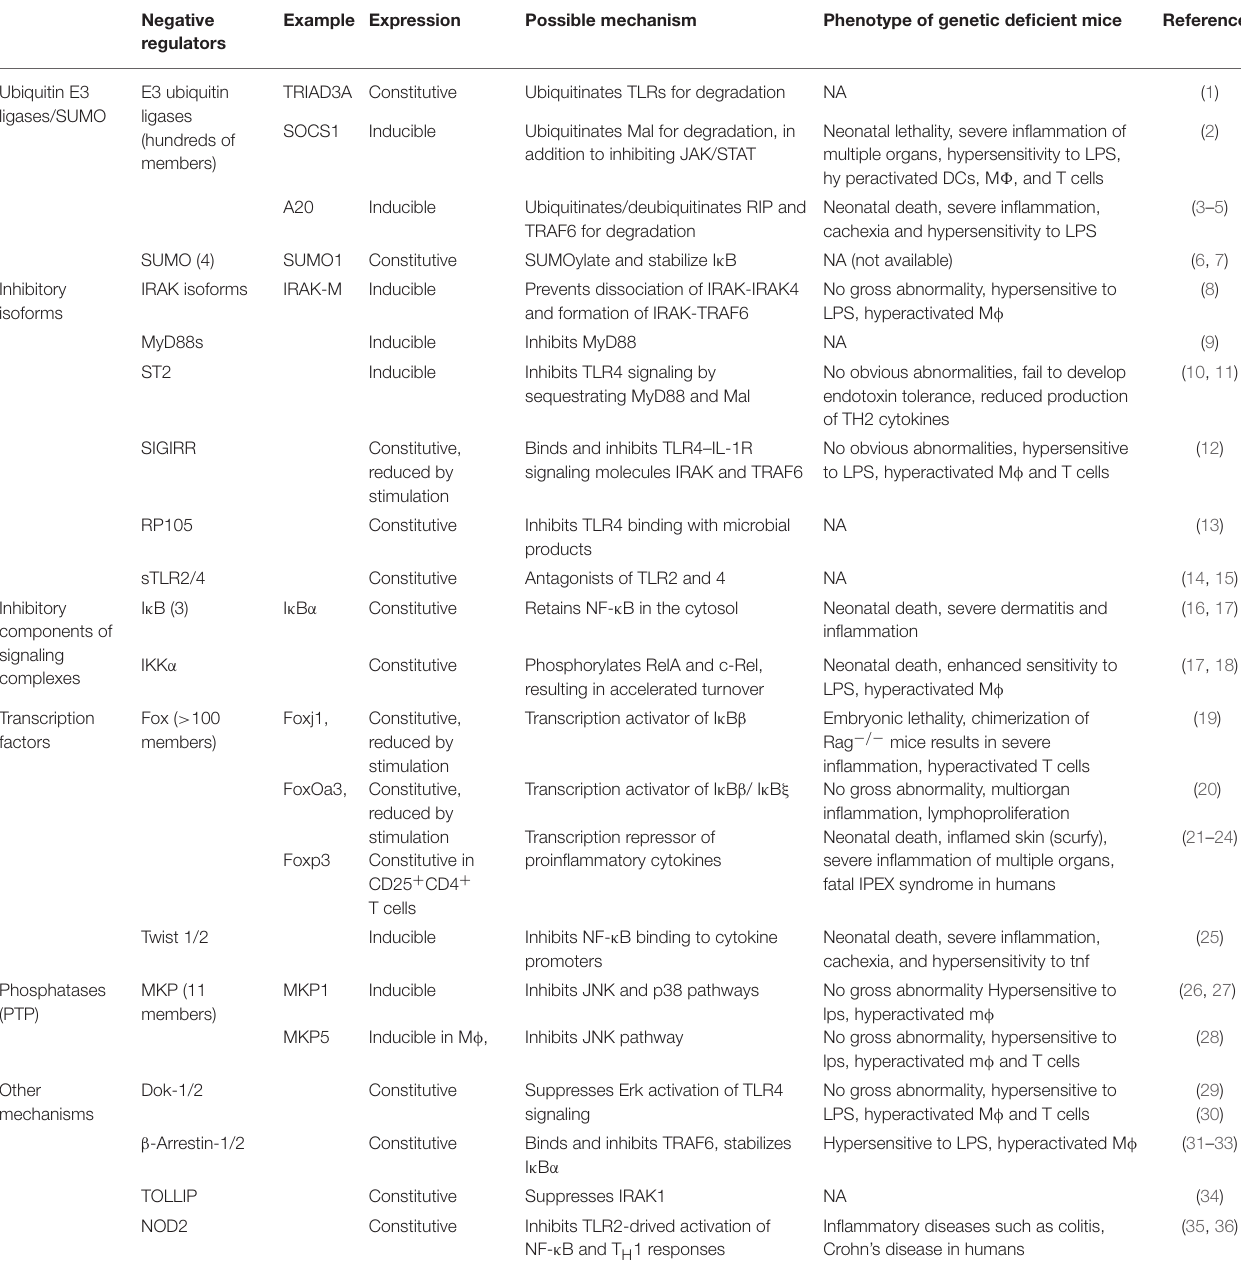
TABLE 1 | Representative negative regulators of TLR and related signal transduction